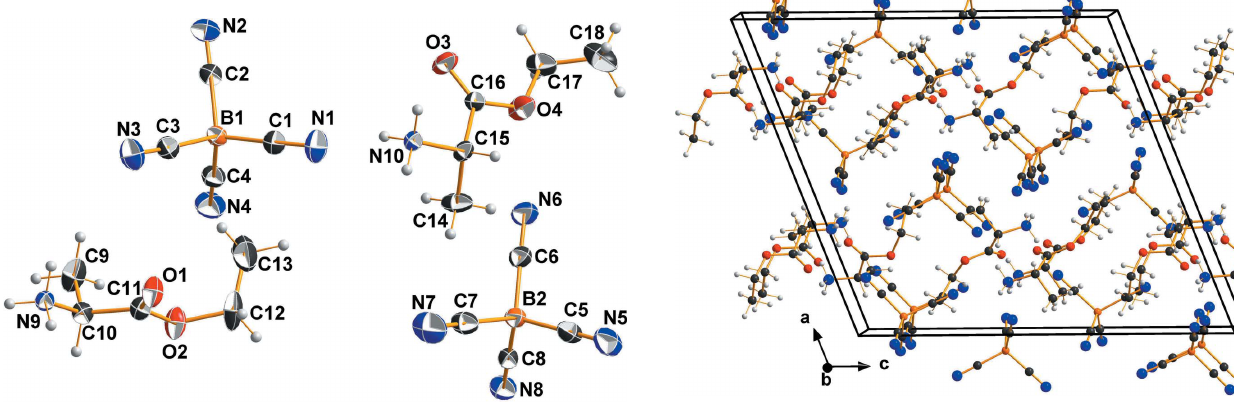
Figure 2 A view of the unit-cell contents in projection down the b axis.